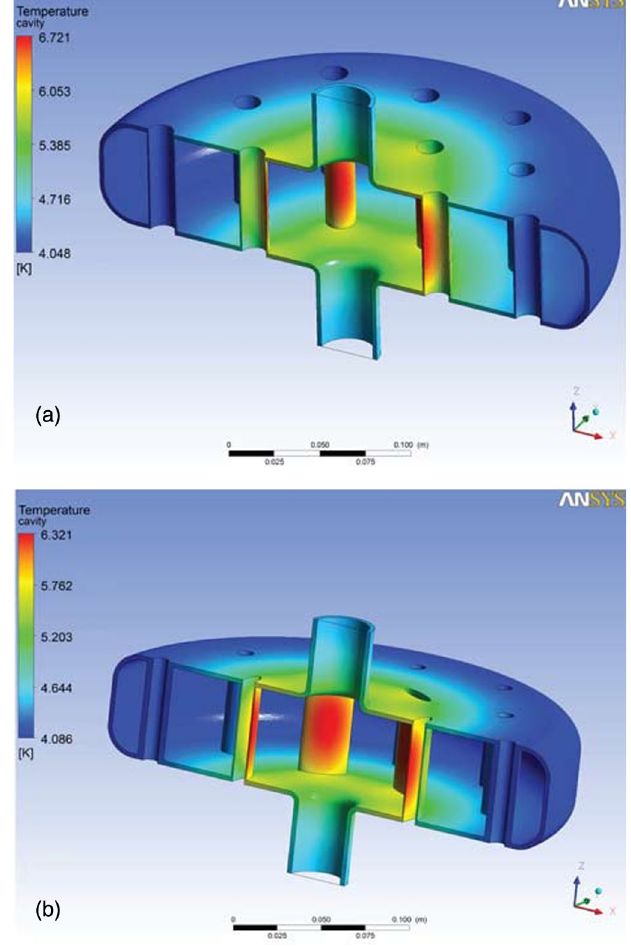
FIG. 12 (color online). Temperature distribution on the surface of a 2.1 GHz SRF PBG resonator immersed into liquid helium at 4 kelvin when operating CW at 10 MV = m accelerating gradient: (a) resonator with round rods; (b) resonator with elliptical